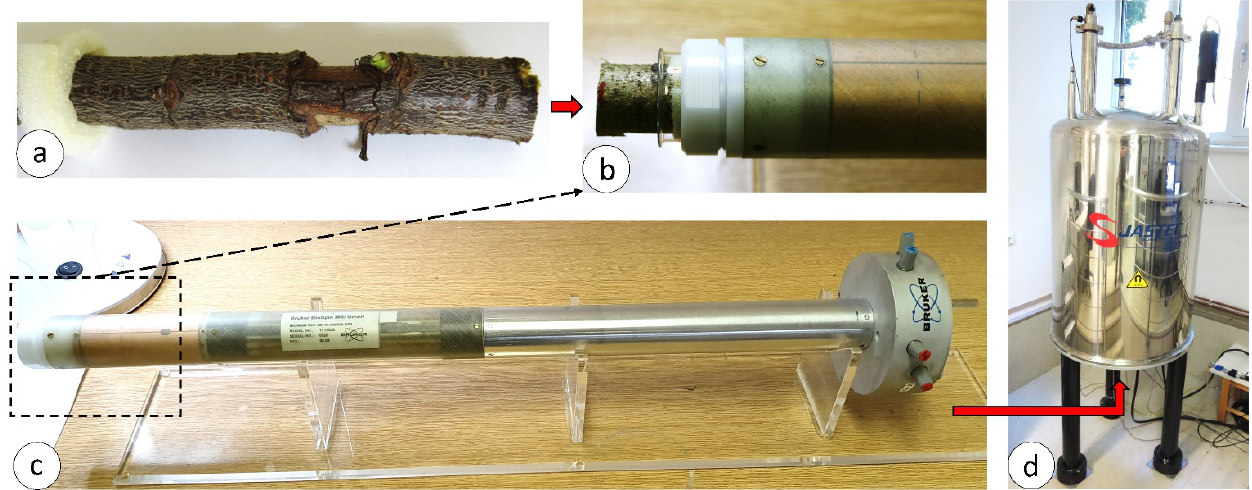
Figure 1. ( a ) Sample PrLa_76 ( Prunus laurocerasus ); ( b , c ) 30 mm diameter RF coil (Brucker, Ettlingen, Germany) and ( d ) MRI spectrometer with a superconducting 9.4 T magnet (Jastec 400, Kobe, Japan).